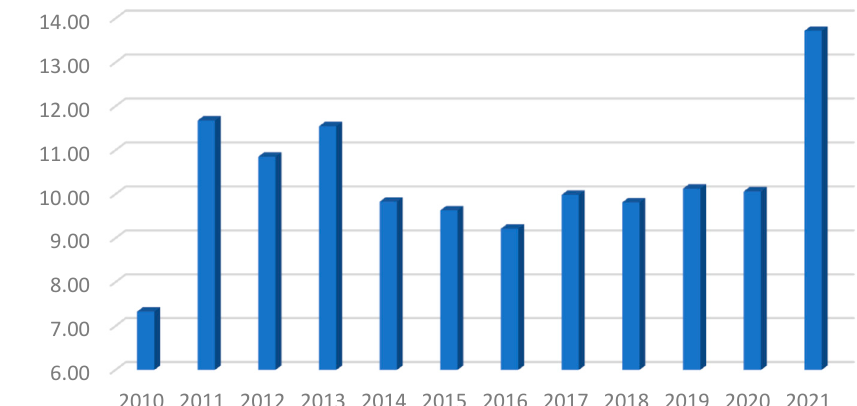
Figure 2. Agriculture insurance (source: United States Department of Agriculture [19]).